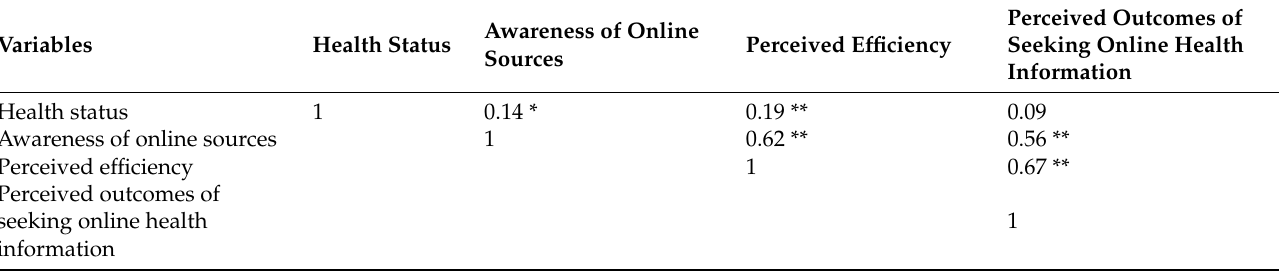
Table 4. Pearson correlations between the